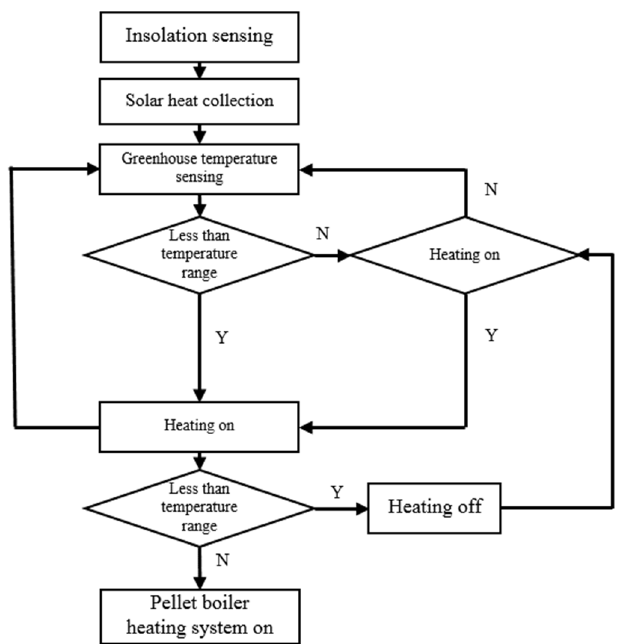
Figure 5. Schematic of hybrid system 2.